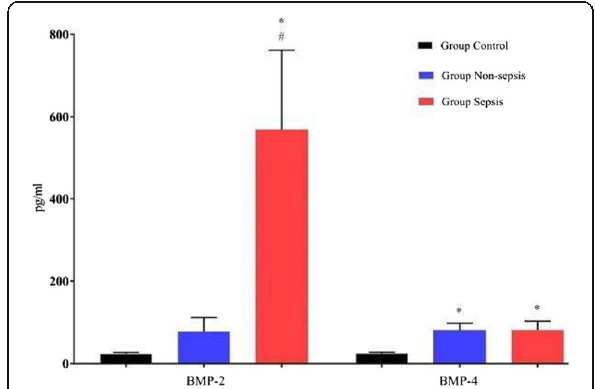
Fig. 1 (abstract 0122). Comparisons of BMP-2 and BMP-4 between group sepsis, group non-sepsis and group control